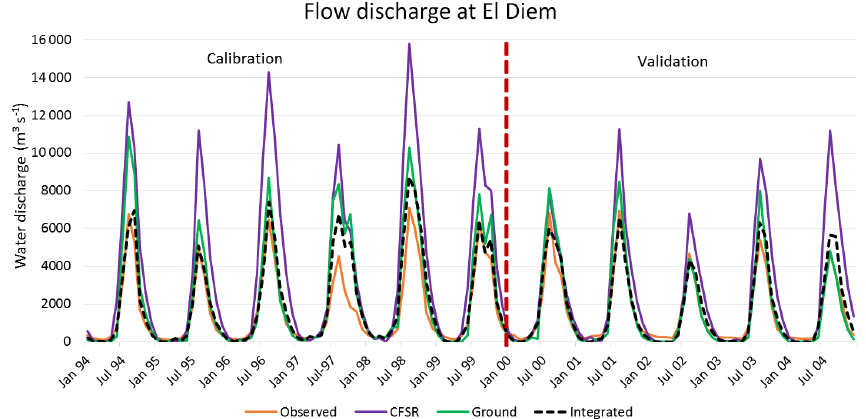
Figure 8. Calibration and validation of SWAT87 at El Diem. Calibration results achieved R 2 and NS values of integrated data: 0.92, 0.80; ground data: 0.92, 0.43; and CFSR data: 0.96, − 1.54, respectively. Validation results achieved R 2 and NS of integrated data: 0.94, 0.91; ground data: 0.95, 0.85; and CFSR data: 0.89, − 0.05,